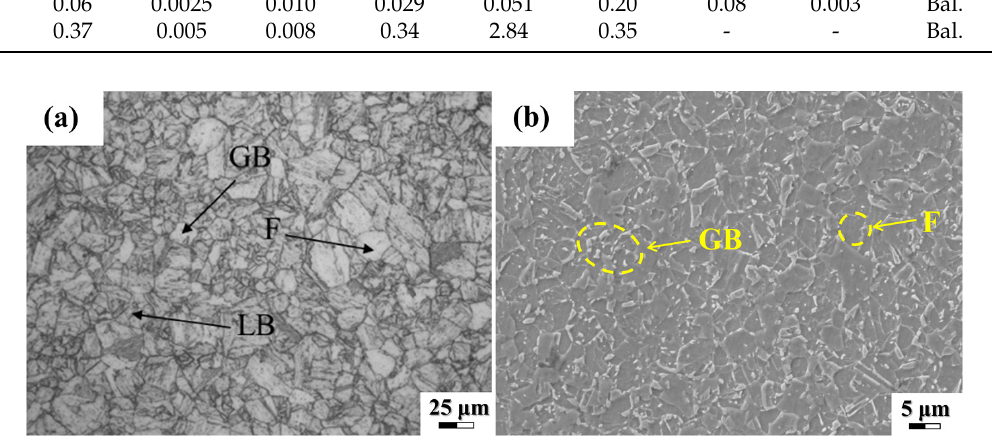
Table 1. Main alloying elements of the BM and ER80YM filler wire (wt.%). Materials